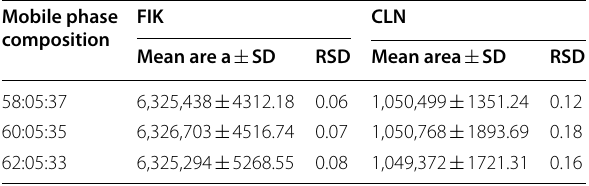
Table 7 Result for change in mobile phase composition (